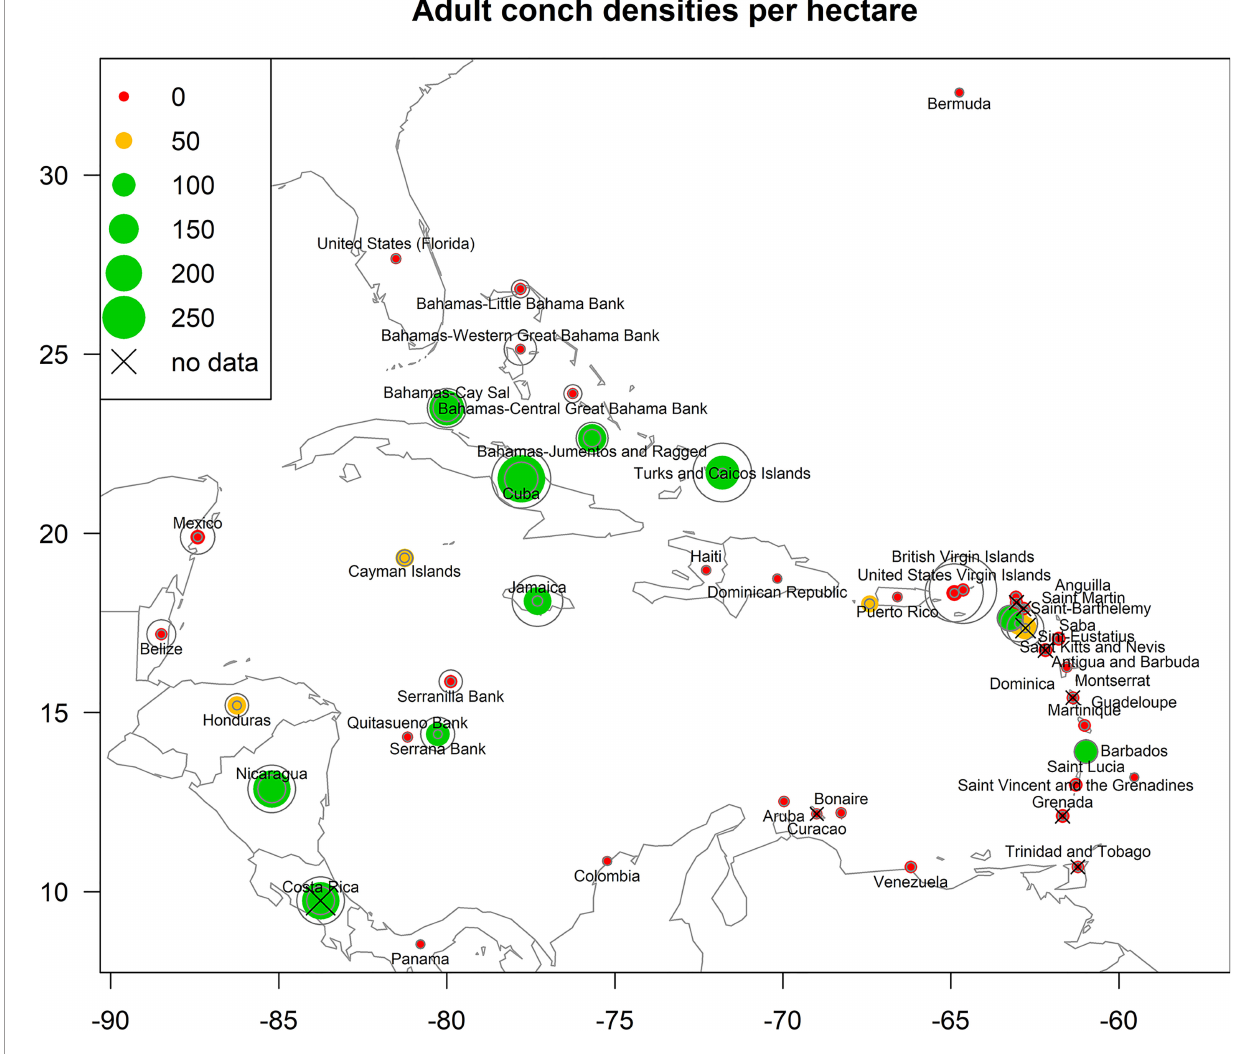
FIGURE 3 | Estimated adult conch densities for the jurisdictions considered in this study (reproduced from Horn et al. 2022, sources listed in Appendix 1 ). Data points are sized relative to densities; green symbols indicate conch populations with >100 adult conch/ha, gold symbols indicate 50-99.9 adult conch/ha, and red symbols indicate <50 adult conch/ha. Countries without density data are indicated with an X - data for these countries were interpolated from the nearest neighbor. Gray circles represent the 95% con fi dence interval (2.5 - 97.5% bounds) of density estimates for each jurisdiction. Where densities are summarized on a jurisdiction level, the points appear at the approximate center point of the jurisdiction; where densities are summarized on a subregional level the points appear at the location of fi shing banks or subregions ( i.e., The Bahamas and Puerto Rico). Please refer to Horn et al. 2022 for more details on the